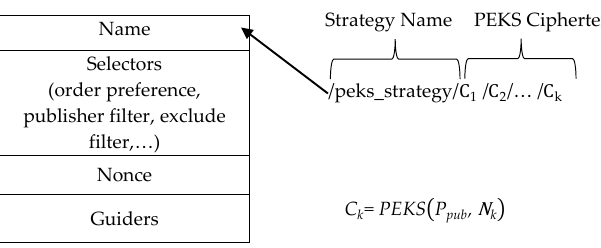
Figure 9. Interest packet with PEKS